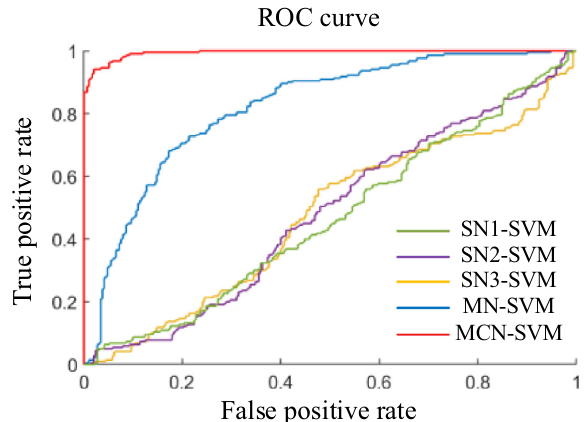
Fig. 1 ROC curves of different methods on the early PD vs. HC classi fi cation. SN1 = sliding-window-based networks (with window length of 1000, step length of 500); SN2 = sliding-window-based networks (with window length of 1000, step length of 1000); SN3 = sliding-window-based networks (with window length of 500, step length of 500); MN = microstate-window-based networks; MCN = microstate-class-window-based